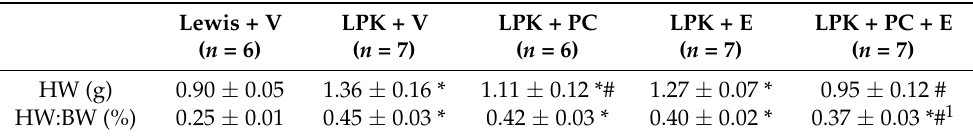
Table 5. Effect of delayed treatment of paricalcitol, enalapril and combination therapy on cardiac enlargement LPK rats at week